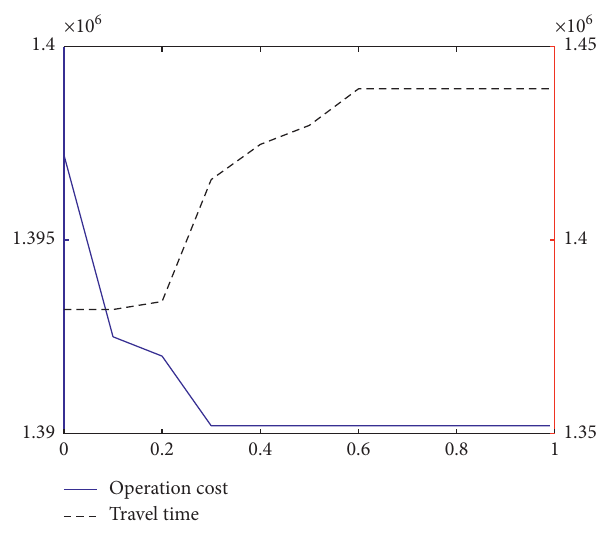
Figure 8: Influence of the weighting